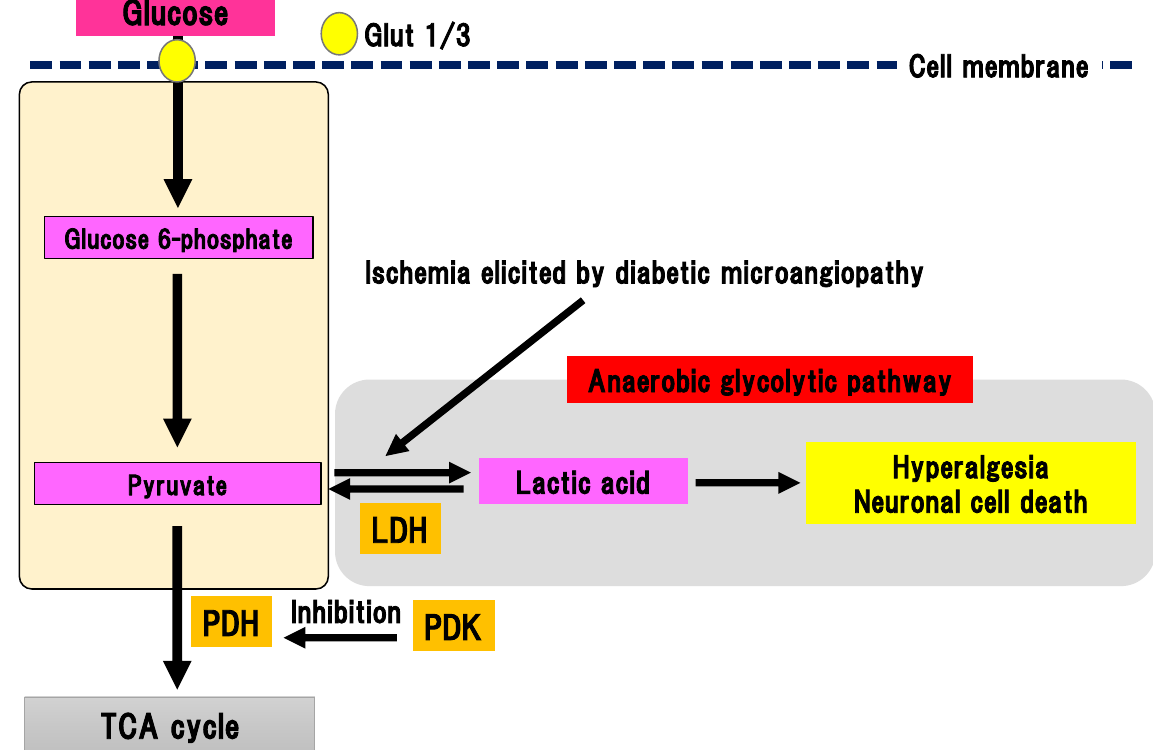
Figure 7. Anaerobic glycolytic pathway. Pyruvate is metabolized to lactic acid by lactate dehydrogenase in anaerobic conditions evoked by ischemia in diabetic microangiopathy. Glut, glucose transporter; LDH, lactate dehydrogenase; PDH, pyruvate dehydrogenase; PDK, PDH kinase; TCA cycle, tricarboxylic acid